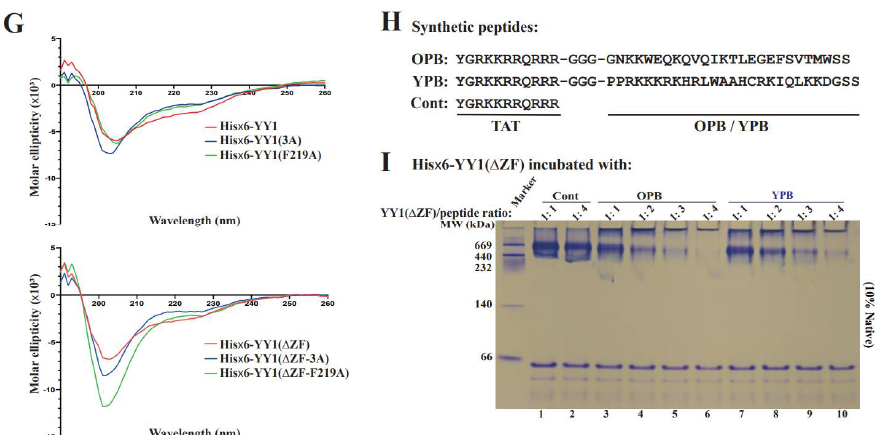
Figure 3. Characterization of key amino acids in charge of YY1 intermolecular interaction. ( A ) Diagrams of OPB point mutations to determine key hydrophobic amino acids involved in intermolecular interactions among YY1 molecules. ( B ) Evaluation of YY1 interaction with OPB wt and mutants. Plasmids of Flag-EGFP-OPB wt and mutants were individually cotransfected with the HA-YY1 expression vector, followed by IP of the Flag antibody and Western blot analyses using labeled antibodies. ( C ) Examination of the effects of OPB wt and mutants on YY1 intermolecular interaction. Plasmids of mCherry-OPB wt, mutants, and cont were individually cotransfected with Flag-YY1( ∆ ZF) and HA-YY1( ∆ ZF), followed by IP using the Flag antibody and Western blot analyses using labeled antibodies. ( D ) Evaluation of the interaction between YY1 and YY1 with wt or mutated OPB sequence. Plasmids of Flag-EGFP-YY1(wt) and OPB mutants were individually cotransfected with HA-YY1( ∆ ZF), followed by IP using the Flag antibody and Western blot analysis using labeled antibodies. ( E ) Native polyacrylamide gel electrophoresis (PAGE) to evaluate the effects of OPB wt and mutants on YY1 intermolecular interactions. Purified His × 6-YY1(wt) and ( ∆ ZF) proteins with OPB of wt, 3A or F219A sequences were analyzed by a 10% native PAGE. The red arrow heads denote the oligomerization of YY1 proteins. ( F ) IP studies to examine the binding protein patterns by OPB wt and mutants. HeLa cells were individually transfected by Flag-EGFP-OPB wt, different OPB mutants, YPB, cont and no insert vectors, followed by IP using the Flag antibody, resolved by native gels or SDS-containing gel and analyzed by Western blot using the Flag antibody. ( G ) Circular dichroism spectroscopy of purified YY1 and its mutants. Purified His × 6-YY1(wt) and ( ∆ ZF) proteins (0.05 mg/mL) with wt or mutated OPB domain were individually scanned between the wavelengths from 190 to 280 nm at 20 ◦ C. The data were analyzed by the GraphPad Prism 5.0 software. ( H ) The sequences of the synthetic OPB, YPB and Cont peptides. TAT: a cell-penetrating peptide (CPP) derived from human immunodeficiency virus. ( I ) Examination of the effects of OPB and YPB peptides on YY1 oligomerization. Purified His × 6-YY1( ∆ ZF) protein (6.5 µ g, or 140 pmol) was mixed with synthetic OPB, YPB and Cont peptides with a serial molar ratio of 1:1, 1:2, 1:3 and 1:4, and incubated at 4 ◦ C for 2 h, followed by the analysis of 10% native